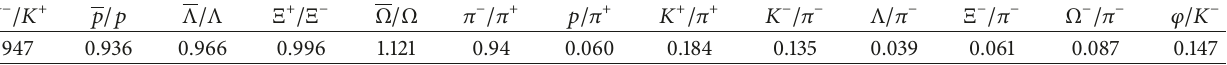
Table 3: Model predictions for hadron ratios at LHC ( 𝑇 = 168.65 MeV, 𝜇 𝐵 = 0.85 MeV). Decay contributions are included.